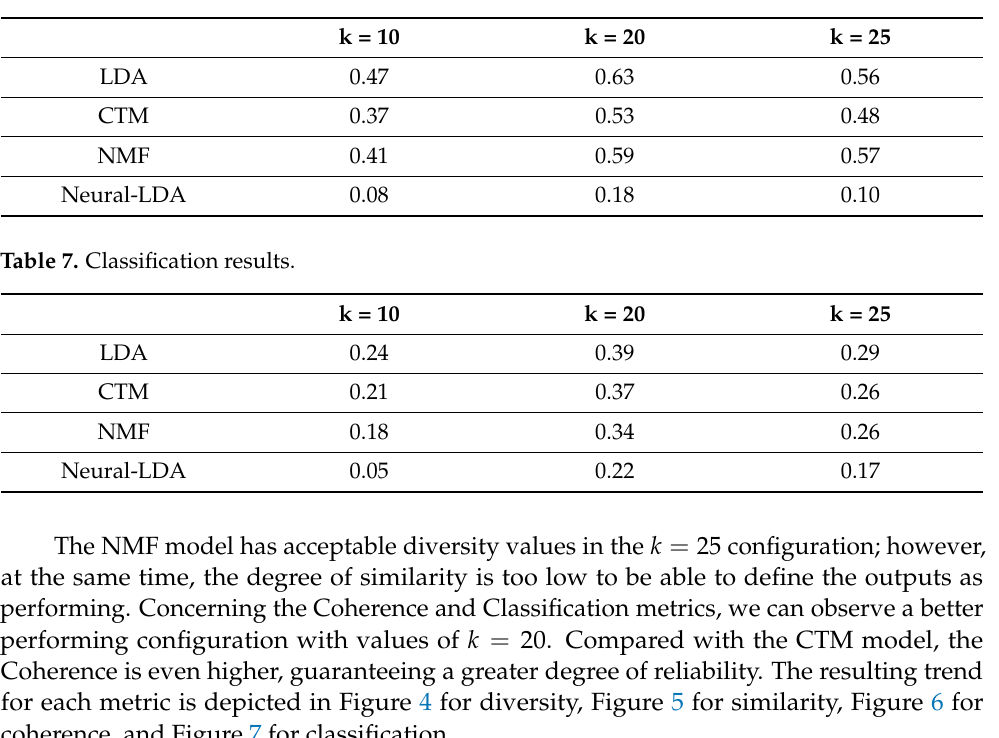
Table 6. Topic Coherence results.